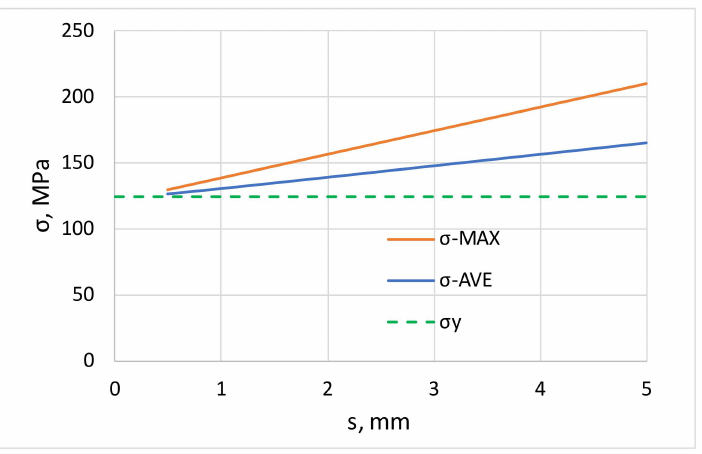
Figure 5. Increase in yield stress and maximum stress due to roller levelling as function of deflection.